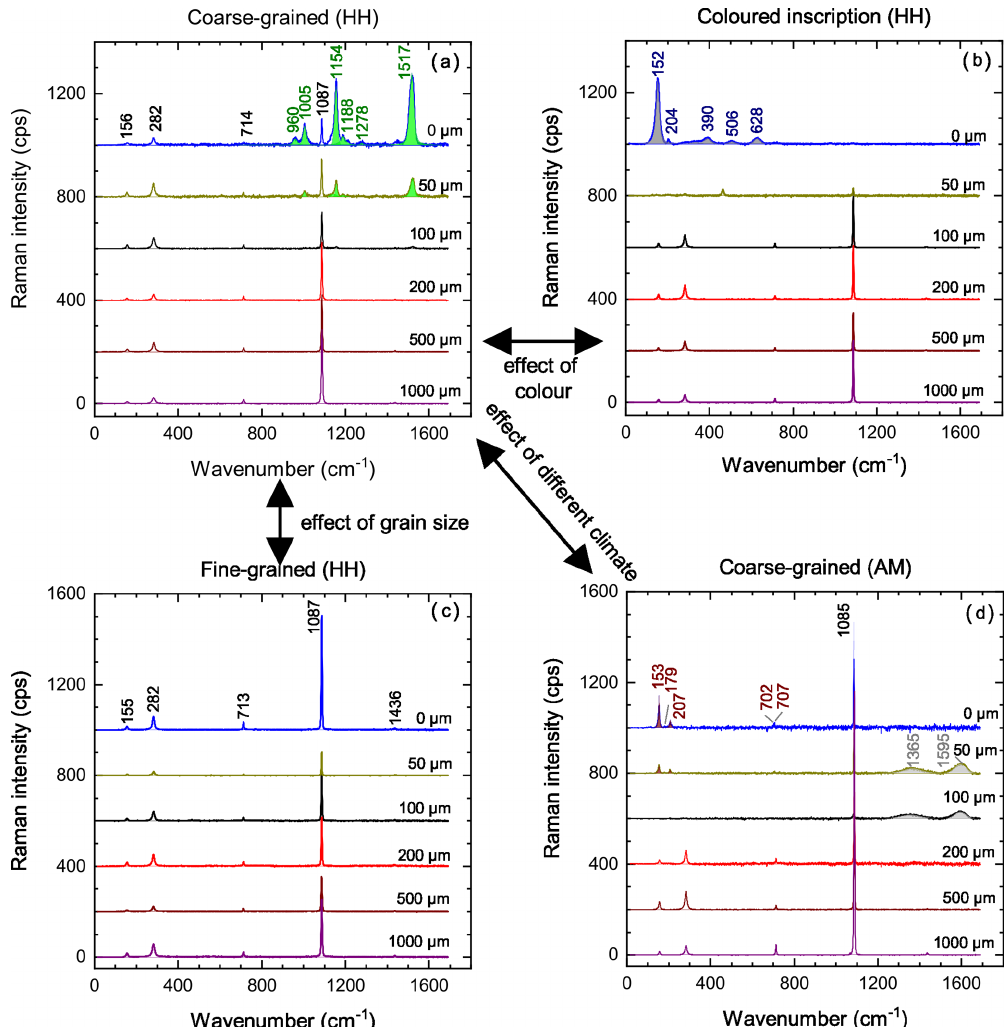
Figure 7. Raman spectra collected along line profiles beneath engravings of selected samples, revealing differences emerging from the effect of colour ( a vs. b ; sample MaD1B_C4L2 vs. MaD1A_C1L4, respectively), grain size ( a vs. c ; sample MaD1B_C4L2 vs. MaE1B_C2L1, respectively), and diverse environmental conditions ( a vs. d ; sample MaD1B_C4L2 vs. Am_C1L1, respectively). The shaded extra peaks in (a) are generated by lichen, those in (b) by anatase, and those in (d) by sooth. Sample AM_C1 (d) exhibits a typical spectrum of aragonite at the surface (0µm) and of calcite for all other points. Black letters in (a) and (c) are indicative of the calcite vibrational modes, while those with green letters characterize additional minerals and compounds (see text for details). Additional peaks at the 0µm level of (b) are attributed to TiO 2 , while those with red and grey colour in (d) are attributed to aragonite and carbonaceous material, respectively. Abbreviations in the figure: C is cut, and L is line. The spectra within the same plot were vertically offset for